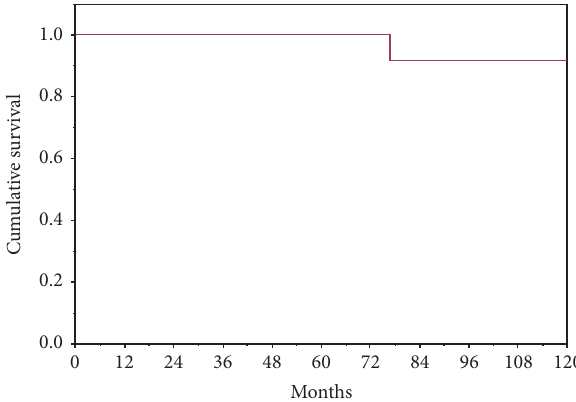
Figure 4: Kaplan-Meier survival curve of patients who underwent pancreatic resection of